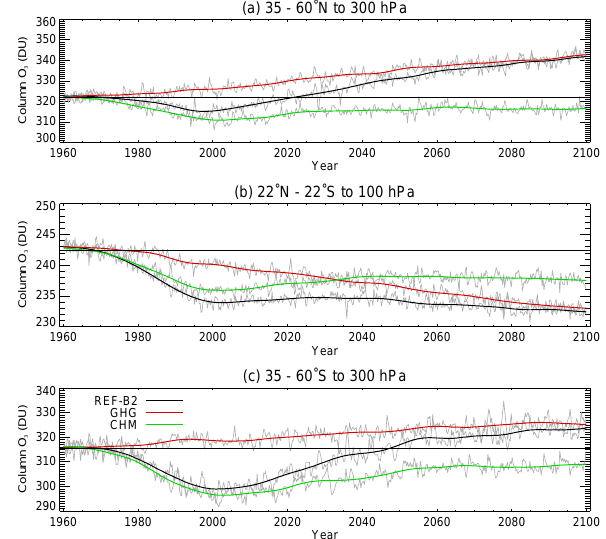
Fig. 9. Time series of ensemble average column ozone from the REF-B2 (black lines), GHG (red lines) and CHM (green lines) experiments over the latitude bands 35–60 ◦ N (a) , 22 ◦ N–22 ◦ S (b) and 35– 60 ◦ S (c) . To avoid contributions from the troposphere, the mid-latitude ozone columns are integrated down to 300 hPa and the tropical columns are integrated to 100 hPa. The grey lines give the seasonal anomalies from the deseasonalized data and the coloured lines are the data after smoothing by a Gaussian filter with a width of eight years. The black horizontal line shows the 1960–1974 average from the three experiments.